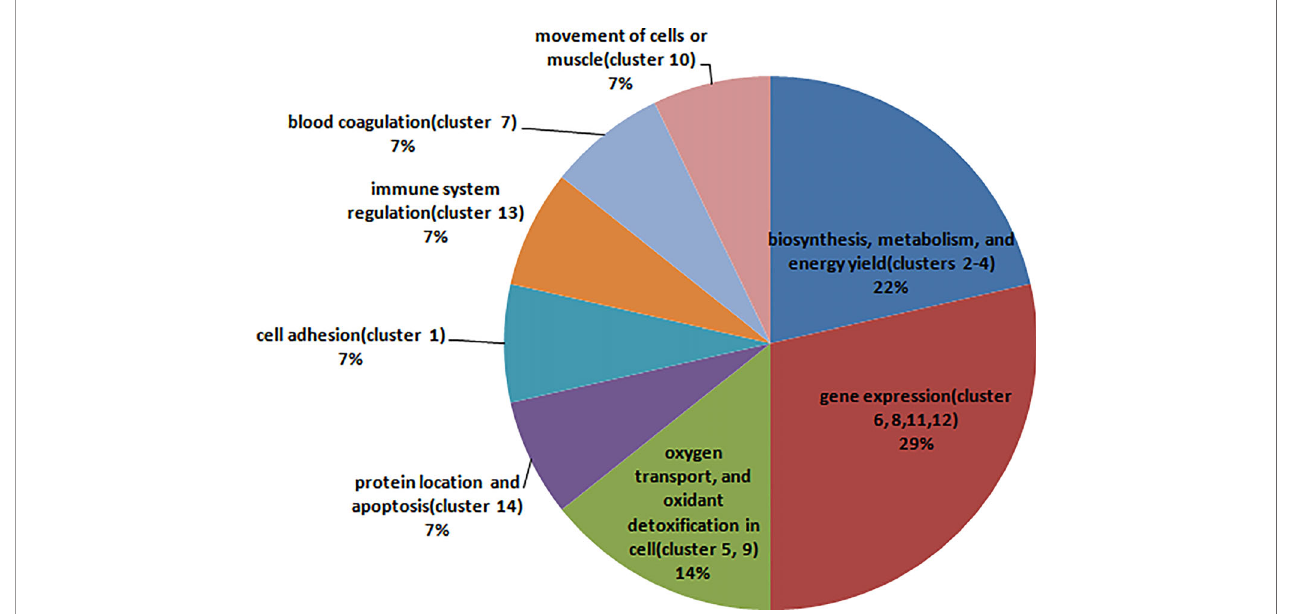
FIGURE 6 | The pie chart shows the main biological function that each cluster involved in, and the percentage that the count of the clusters involved in this biological function accounted for all clusters.